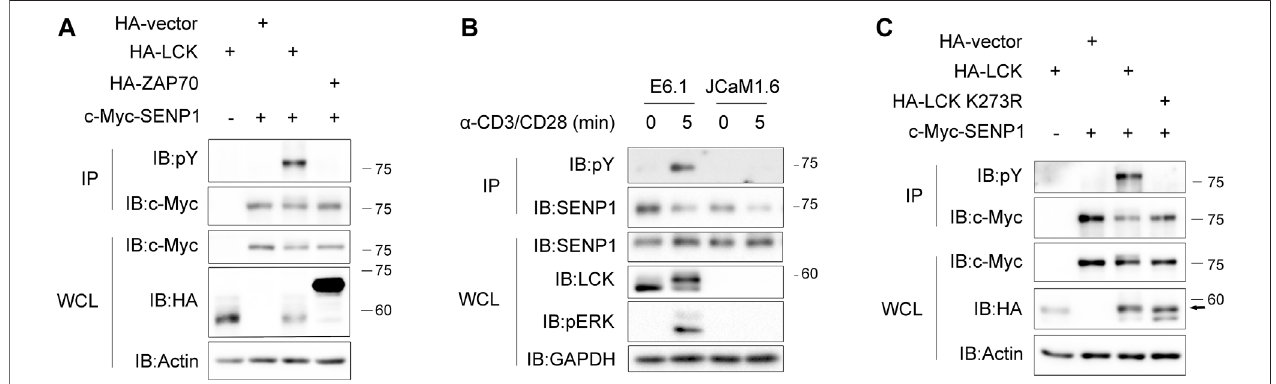
FIGURE 2 | T cell receptor (TCR) induces phosphorylation of SENP1 by Lck. (A) Anti-phospho-tyrosine (pY) immunoblots of c-Myc-SENP1 immunoprecipitates from HEK293T cells cotransfected with c-Myc-SENP1 and HA-Lck or HA-ZAP70 (top) and immunoblots of WCL of HEK293T transfectants (bottom). (B) Anti-pY immunoblots of endogenous SENP1 immunoprecipitates from Jurkat E6.1 or Lck-de fi cient JCaM1.6 cells costimulated with anti-CD3 plus anti-CD28 for the indicated times(top)andimmunoblotsofWCLofJurkatE6.1orLck-de fi cientJCaM1.6celllysates(bottom). (C) AnalysisofLckkinaseactivityfortyrosinephosphorylationon SENP1. Anti-pY immunoblots of c-Myc-SENP1 immunoprecipitates from HEK293T cells cotransfected with c-Myc-SENP1 and HA-Lck or HA-Lck K273R (top) and immunoblots of WCL of HEK293T transfectants